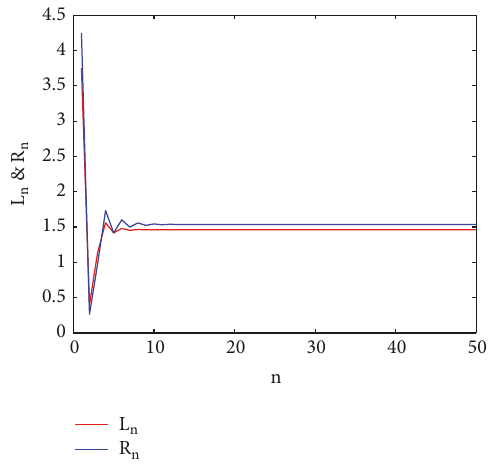
Figure 4: The solution of system (64) at 𝛼 = 0.75.